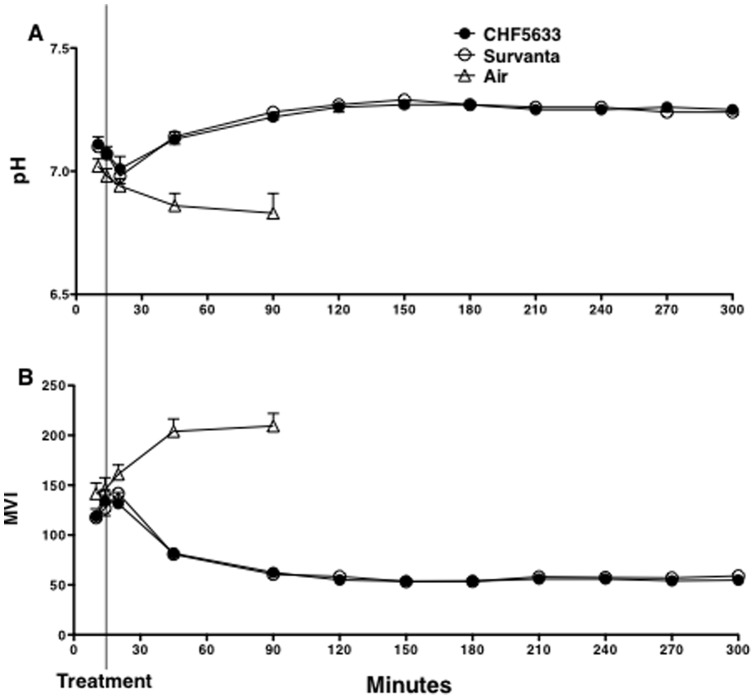
pH and modified ventilation index (MVI).(A) In spite of ventilation with high PIP for 15 min after birth, pH was decreased in association with high Pco2. pH was improved after CHF5633 or Survanta treatment. (B) MVI was calculated as peak inspiratory pressure x Pco2 x respiratory rate/1,000. MVI was similarly improved by CHF5633 and Survanta treatment. Some error bars are within symbols.